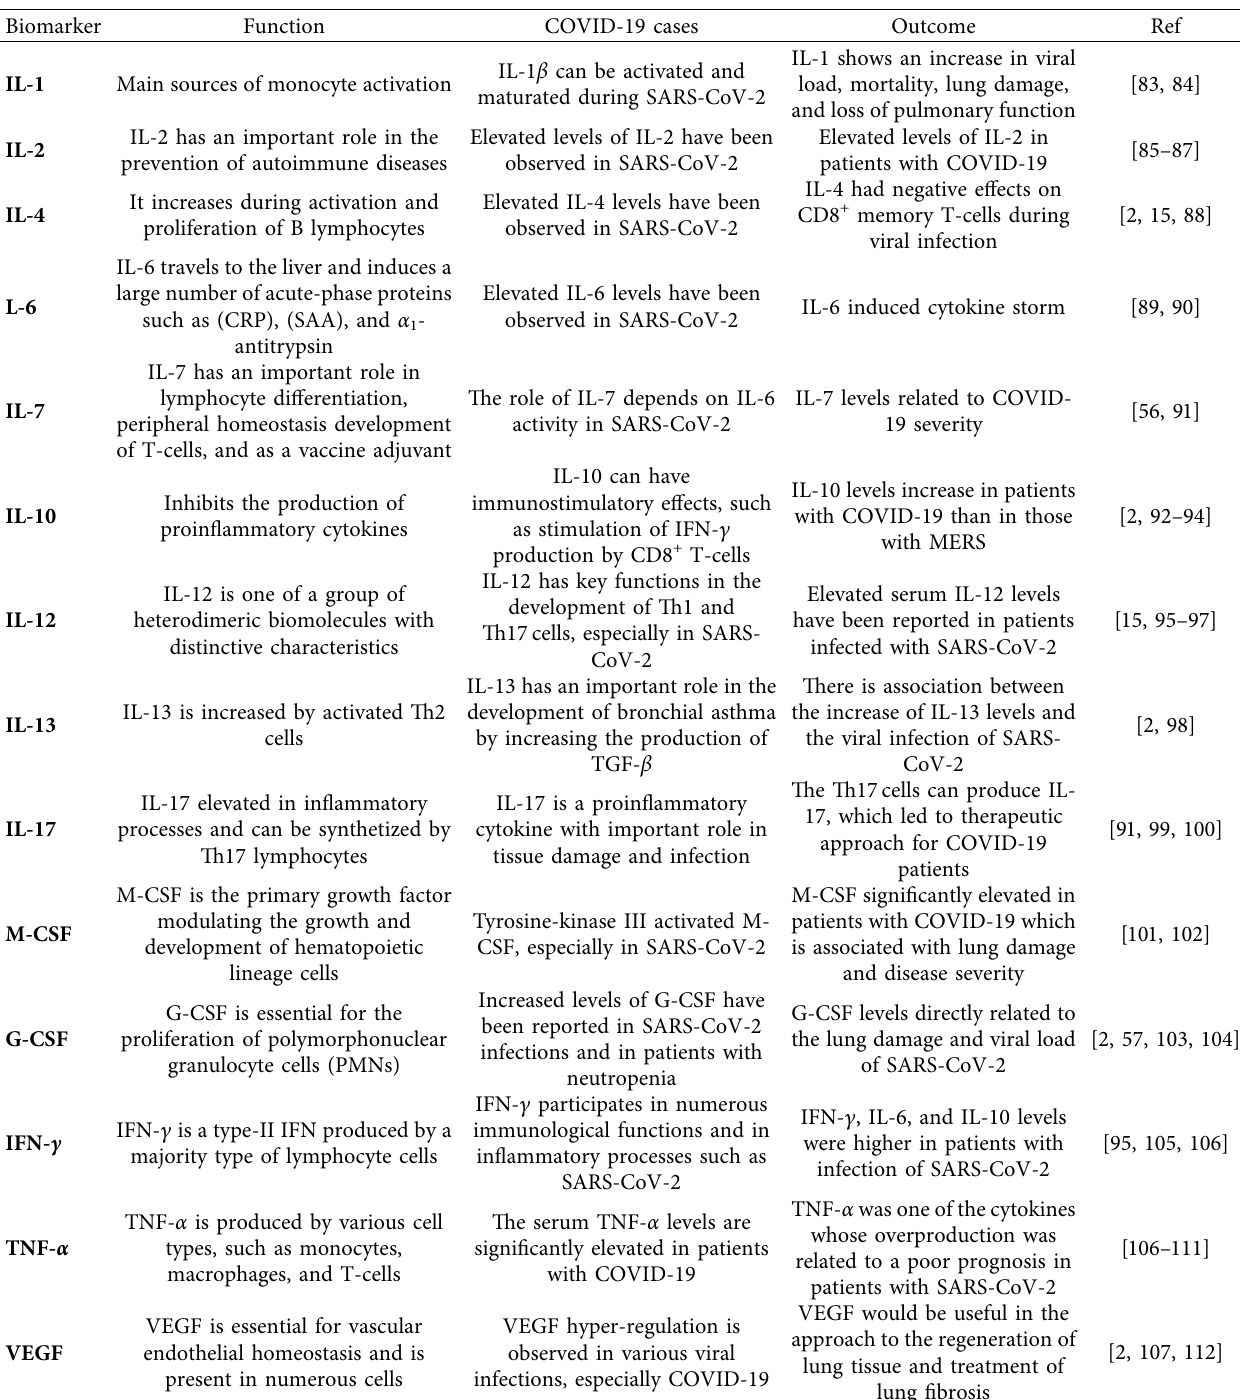
Table 1: The important inflammatory factors associated with COVID-19